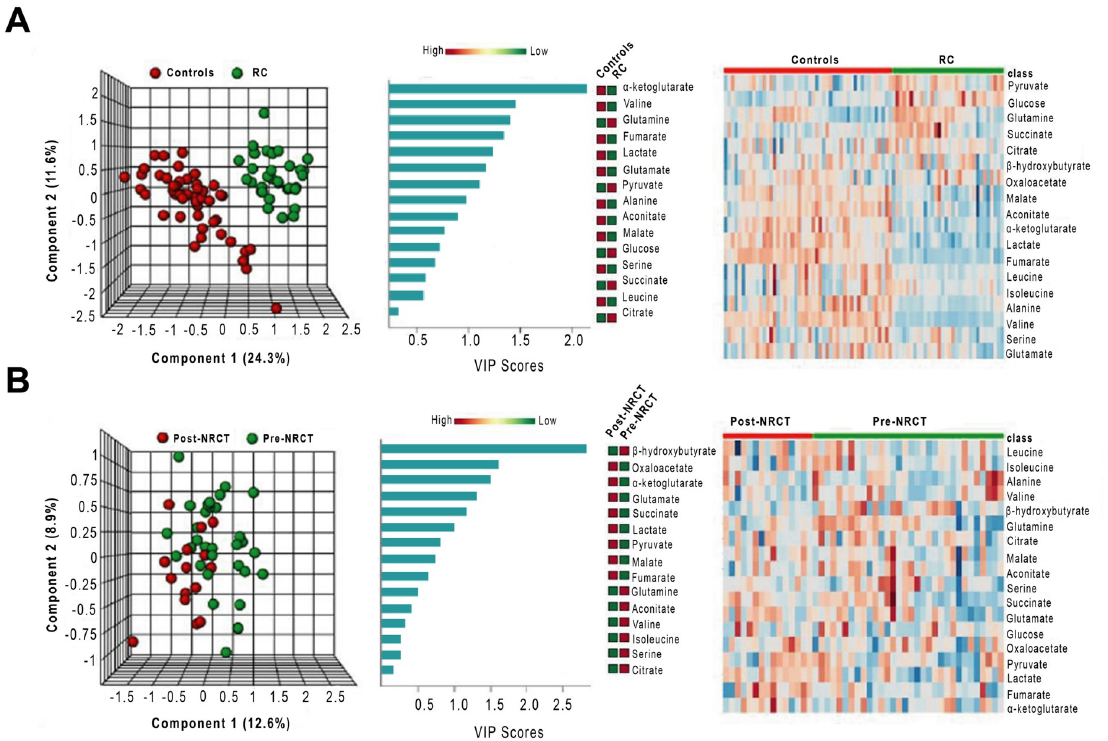
Fig 3. Multivariate analysis of plasma metabolites patients with Rectal Cancer (RC) and the control group pre- and post-Neoadjuvant Radiochemotherapy (NRCT). From left to right, partial least square discriminant analysis (PLSDA), variable importance in projection (VIP) scores of the PLSDA and heatmap analyses comparing RC patients and control group (A) and RC patients pre- and post-NRCT (B). https://doi.org/10.1371/journal.pone.0250453.g003 (sensitivity = 87%, specificity = 48%) for succinate, and AUC = 0.755 (sensitivity = 87%, speci- ficity = 70% for glutamate). Fig 8 represents a correlation network of the grouping of metabolites from each study group. We identified some stronger commonalities and positive connections in the post- NRCT group compared to the control and pre-NRCT groups (Fig 8A). We drew dot plots to show the precise influence of each individual metabolite to the total score for the pool of metabolites (Fig 8B). When comparing the control group with the RC patients pre-NRCT, we observed that the most relevant pathways in metabolic alterations were the citric acid cycle Table 5. Multiple regression analysis of the combined effect of clinical and demographic characteristics on plasma α -ketoglutarate concentration. B SE t p-value